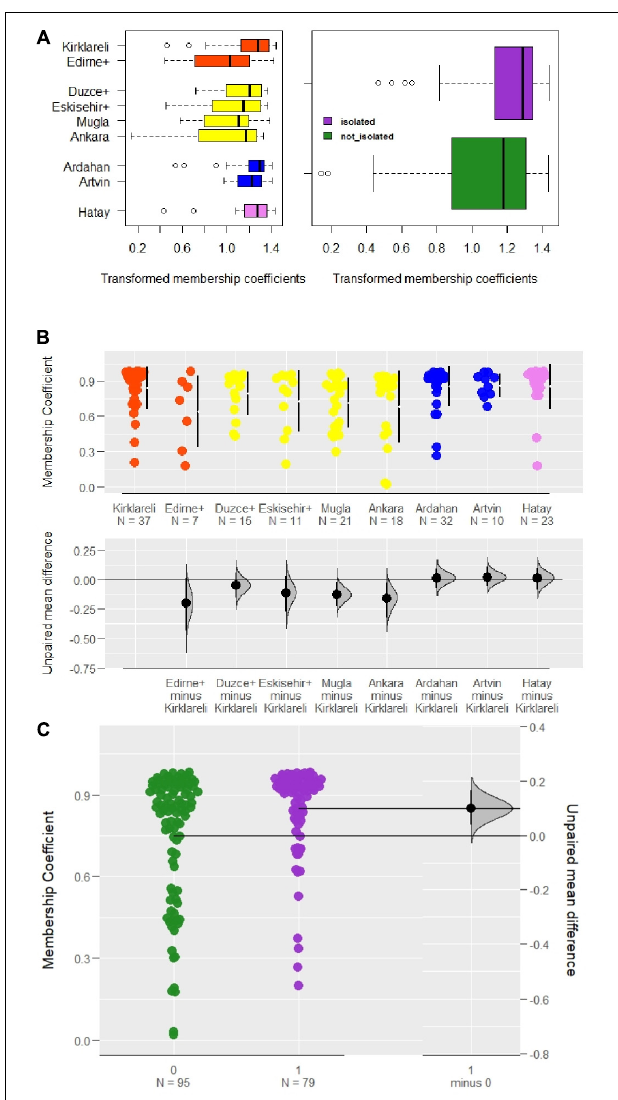
FIGURE 5 | Samples within isolated regions assigned to their clusters with higher probabilities in contrast to samples from regions open to migratory beekeeping. (A) The first boxplot displays the arcsine square-root transformed membership coefficients for nine populations, whereas the second one presents a comparison of samples within isolated regions and those are not ( p < 0.001). (B) Scatter plot based on a comparison of raw individual membership coefficients to their native clusters for nine populations against Thracian samples. Bars right to the data points refer to the 25 and 75% quartiles and the gap between them is the median value for the sample. Note that despite lacking a conservation status, samples from Hatay and Düzce + have membership coefficients comparable to those of Kırklareli, Ardahan, and Artvin which are isolated regions. (C) Scatter plot contrasting individual raw membership coefficients with an estimation of the mean difference between isolated regions and those are not (orange: Thracian, yellow: Anatolian, blue: Caucasian, violet: Levantine clusters; orchid and “1”: isolated regions, green and “0”: regions open to migratory beekeeping). The zero-line corresponds to the mean membership coefficient of colonies in regions open to migratory beekeeping. The Euclidean distance of the colonies in isolated regions from that mean is shown as a dot with a 95% confidence interval bar around. The distribution of the estimation statistic is included to account for the